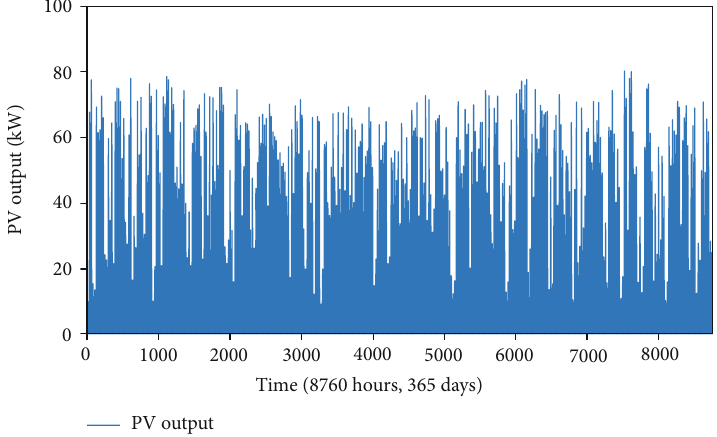
Figure 15: PV power output of the o ff -grid PV minigrid system with storage.